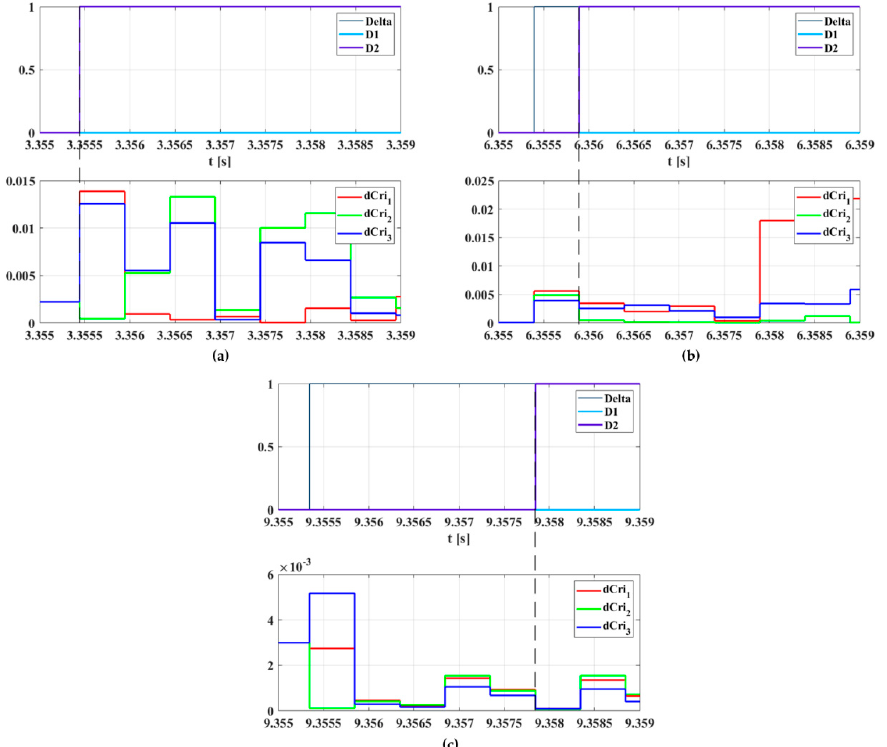
Figure 4. Detector responses and transients of marker errors during lack of signal: ( a ) measurement white Gaussian noise (70 dB); ( b ) variable gain (1.2 i a ) ; ( c ) in phase B in experimental tests.